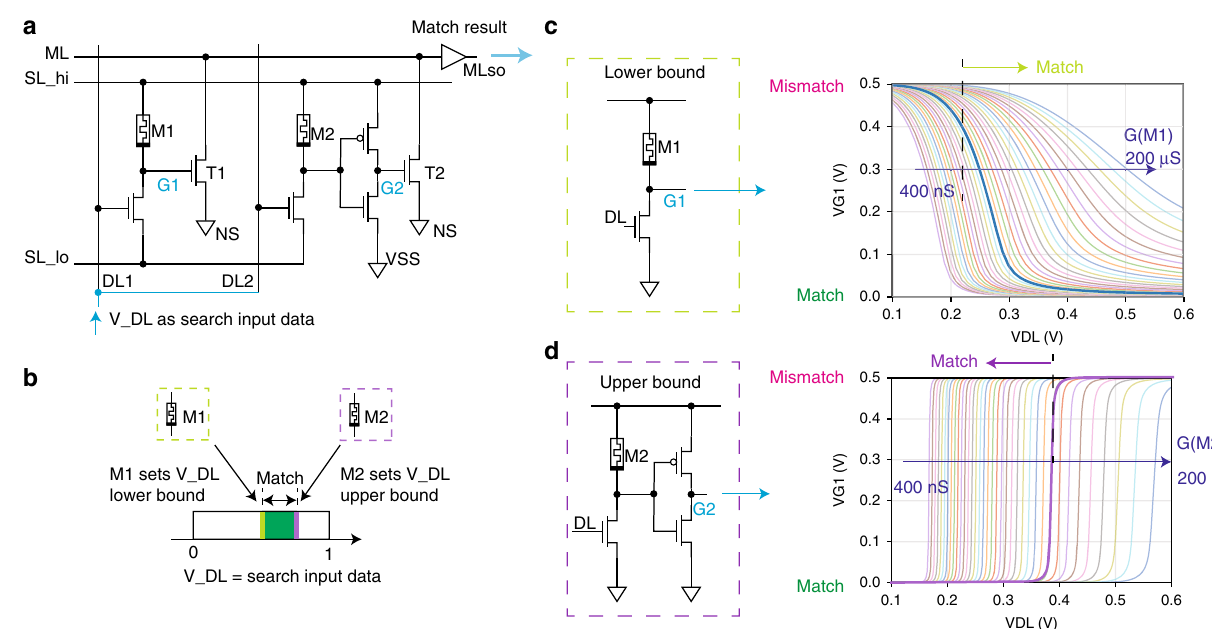
Fig. 2 6-transistors 2-memristors analog content-addressable memory circuit. a Schematic of our proposed analog CAM circuit, composed of six transistors and two memristors (6T2M). Voltage amplitude on the Data Line (DL) provides search input and the matching result is sensed as the voltage level on the Match Line (ML). b “ Match ” result when the analog input is within the range (narrow green band) stored by the cell. The stored range